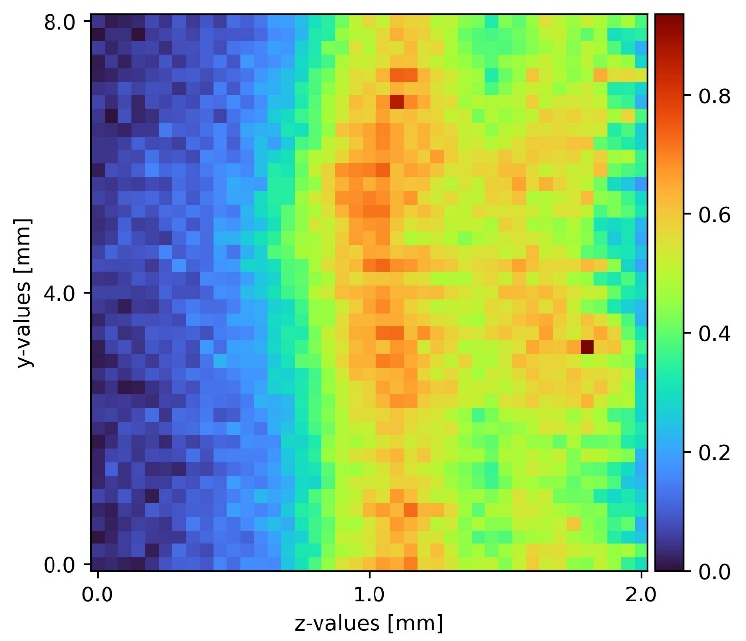
Figure 6. Sodium sulfate film on a plain surface falling film; measurements are located after the disturbance.